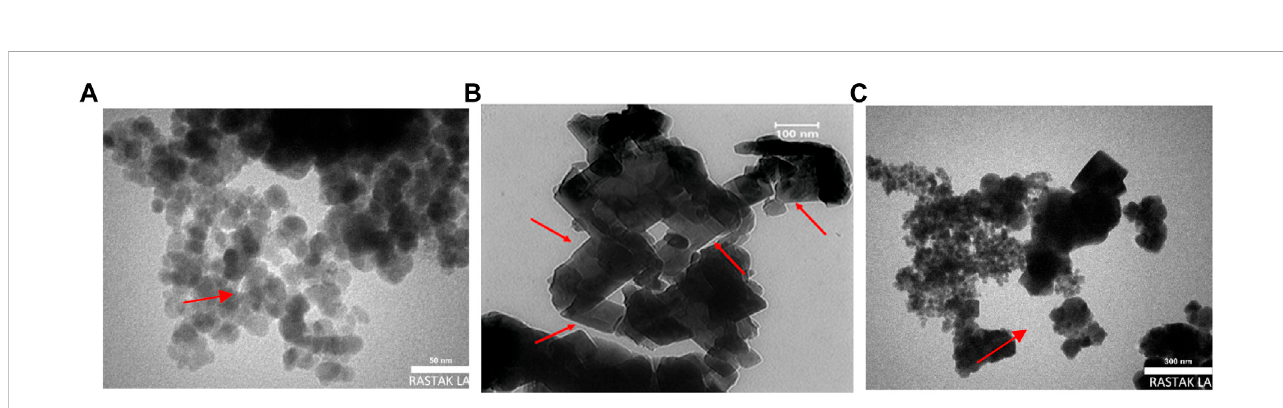
FIGURE 3 TEM analysis of (A) Fe 3 O 4 @SiO 2 , (B) Ti 3 C 2 @FA, and (C) Ti 3 C 2 -Fe 3 O 4 @SiO 2